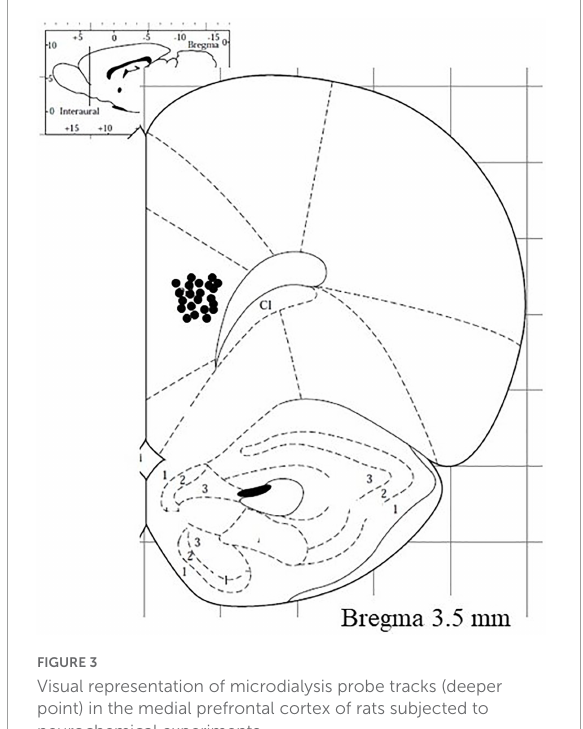
FIGURE3 Visual representation of microdialysis probe tracks (deeper point) in the medial prefrontal cortex of rats subjected to neurochemical experiments.